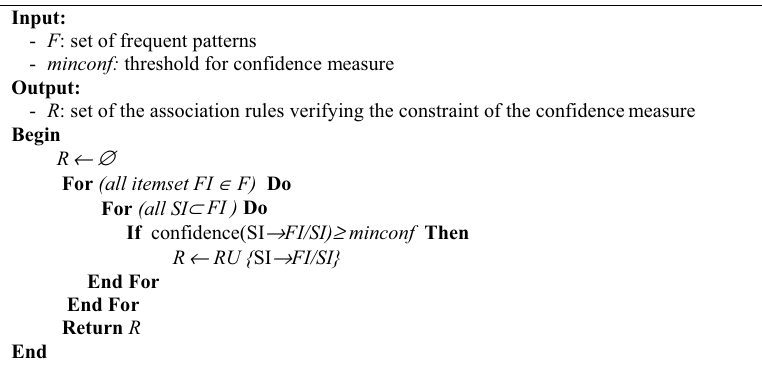
Algorithm 3: Algorithm for extracting association rules from a set of frequent